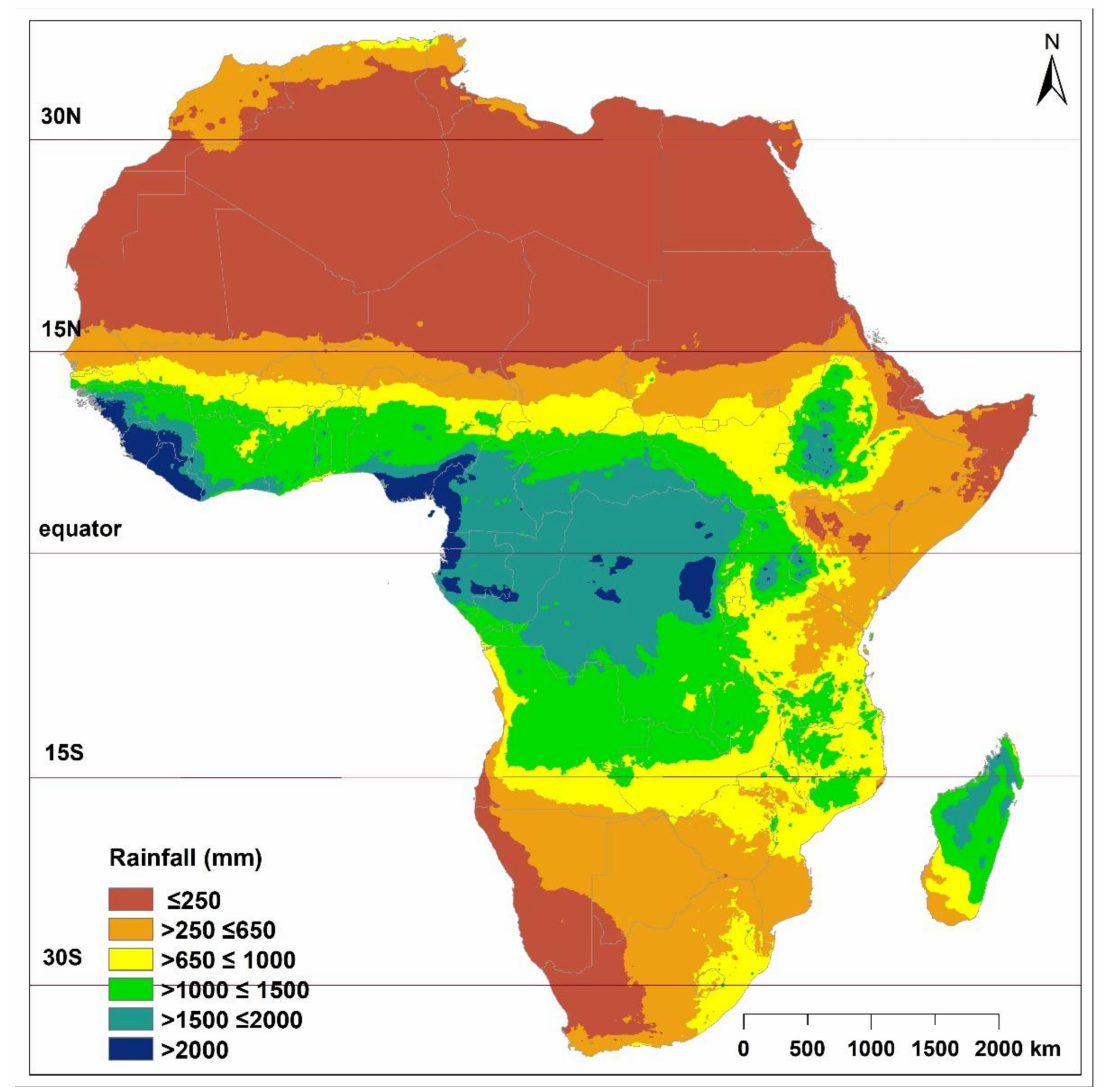
Figure 4. Spatial distribution of annual average rainfall (mm) across Africa from 1983 to